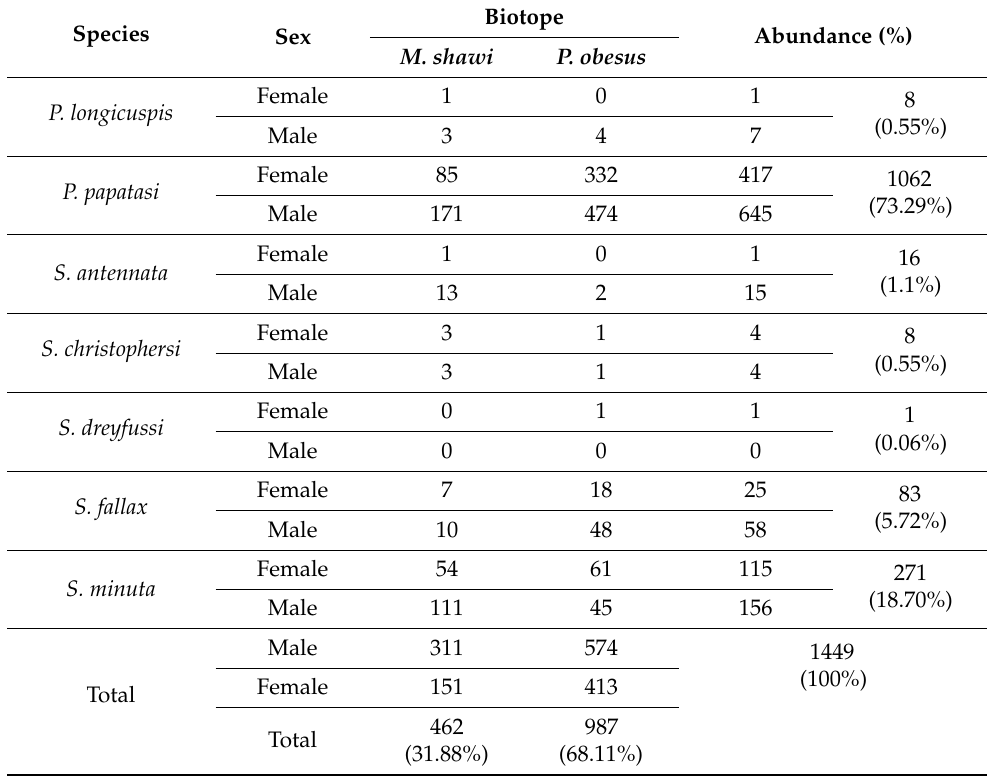
Table 2. Abundance of sand fly species (%) caught in ecotones of Meriones shawi and Psammomys obesus . Species Sex